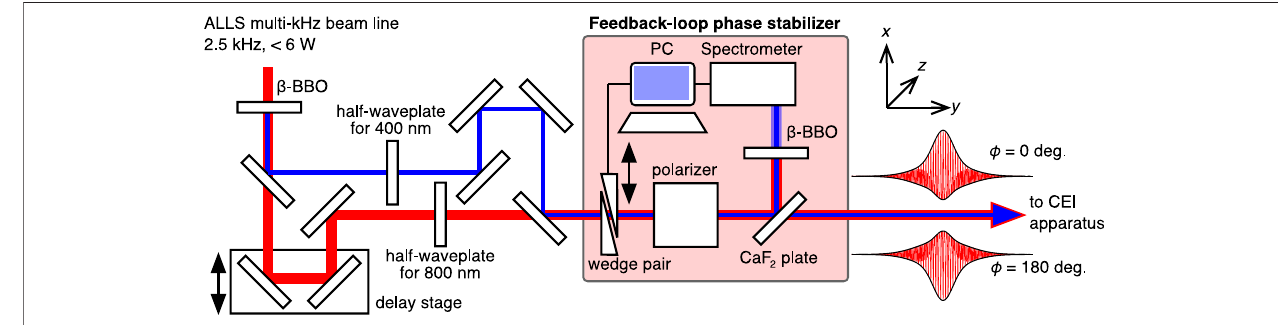
FIGURE 1 | Schematic of the experimental setup to generate phase-locked two-color laser fi elds. The output of a Ti:Sapphire laser ampli fi er system ( ω , 800 nm, 2.5 kHz)wasintroducedintoa β -barium borate(BBO, Type I)crystaltogenerate second-harmonicpulses(2 ω ,400 nm). ω and2 ω pulses wereseparatedbyadielectric mirror.Thepolarizationdirectionofbothpulseswasrotatedbyahalf-waveplateandextractedbyapolarizertoparallelizethepolarizationdirectionsalongthe x -axisinthe laboratory frame and tune the fi eld intensity individually. The time-delay between both pulses was controlled by a linear delay stage before ω and 2 ω pulses were collinearlyre-combined.Apairoffusedsilicawedgeswasusedto fi ne-tunetherelativephase ϕ ,whichwaslockedbyafeedbacklooputilizingtheinterference spectrum of the 2 ω pulses. Schematic shapes of the phase-locked two-color laser electric fi elds ( ϕ =0 ° and 180 ° ) are